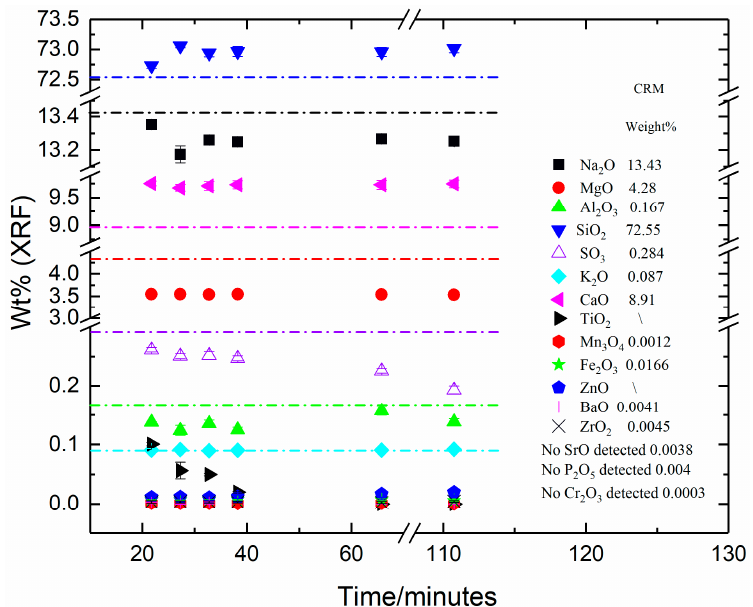
Figure 4. XRF OXI results for CRM-525 [44] (Low-Iron Float Glass) as a function of total process time. Error bars are smaller than the data markers except where shown. Horizontal lines indicate the certified composition of CRM-525. Analysed TiO 2 content includes contribution from I L β 1,2,3 lines.